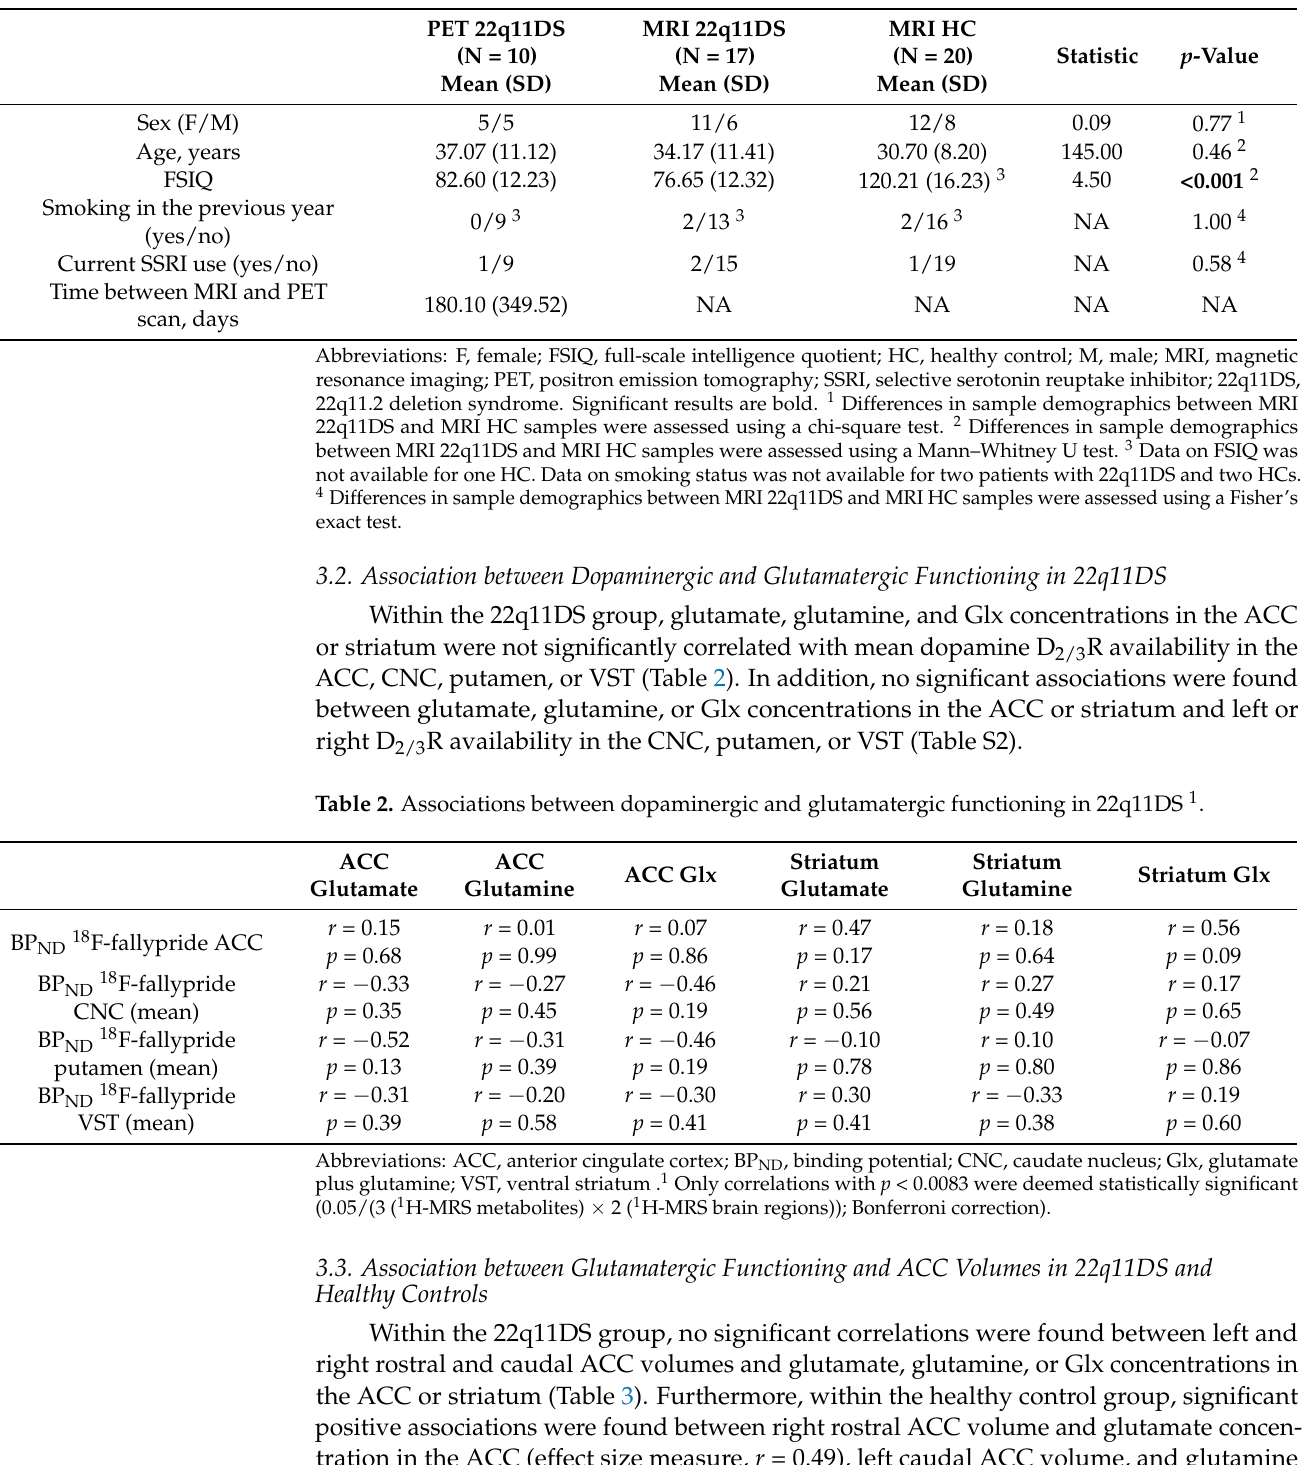
Table 1. Sample demographics.